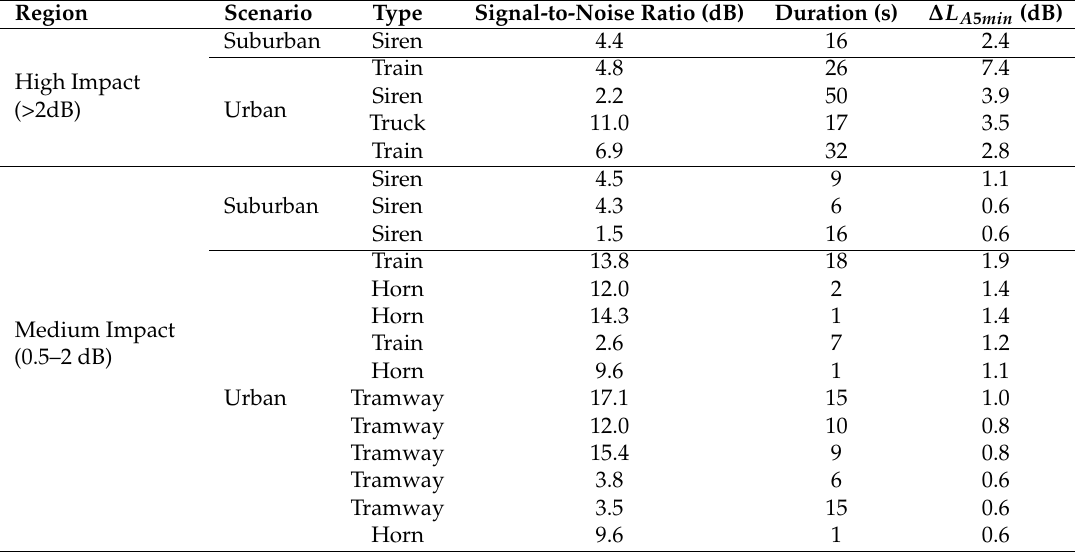
Table 1. Anomalous Noise Events (ANEs) of the high- and medium-impact regions from the suburban (Rome) and urban (Milan)